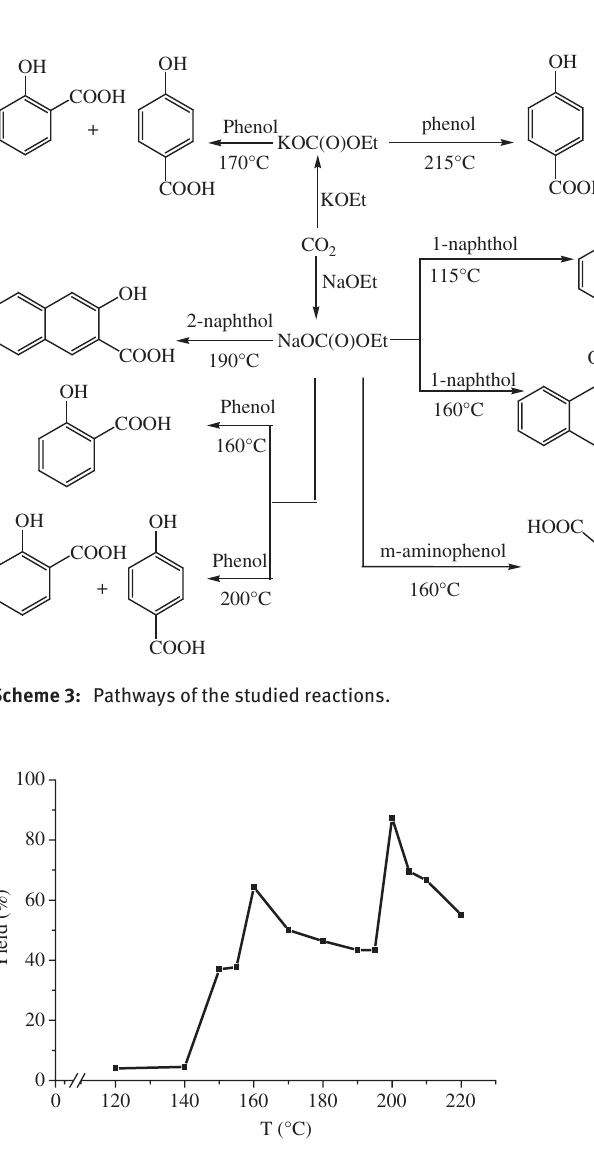
Figure 1: Yield of o-hydroxybenzoic acid versus temperature (heating rate, 35 ° C/h; sodium ethyl carbonate; holding time at the = 10 final temperature, 1 h; P co 2